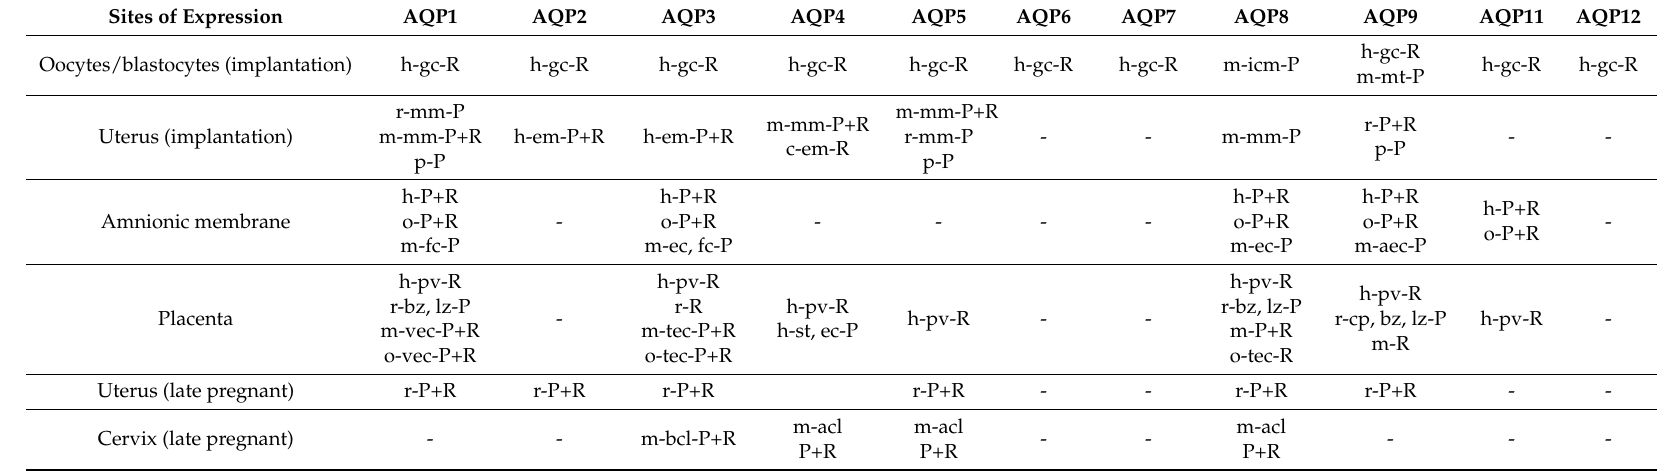
Table 1. The expression of aquaporin (AQP) isotypes (P: protein or R: mRNA) in different mammalian species (h: human; r: rat; m: mouse; c: cattle; o: ovine; p: pig) during pregnancy. aec: apoptotic epithelial cells; acl: apical cell layers of cervical epithelium; bcl: basal cell layers of cervical epithelium; bz: basal zone; cp: complete placenta; ec: epithelial cells; em: endometrium; fc: fibroblast cells; gc: granulose cells; icm: inner-cell mass of blastocytes; lz: labyrinth zone, mm: myometrium; mt: mural trophectoderm of blastocyst; pv: placenta villi; st: syncytiotrophoblast cells; tec: trophoblast epithelial cells; vec: vascular epithelial cells. Sites of